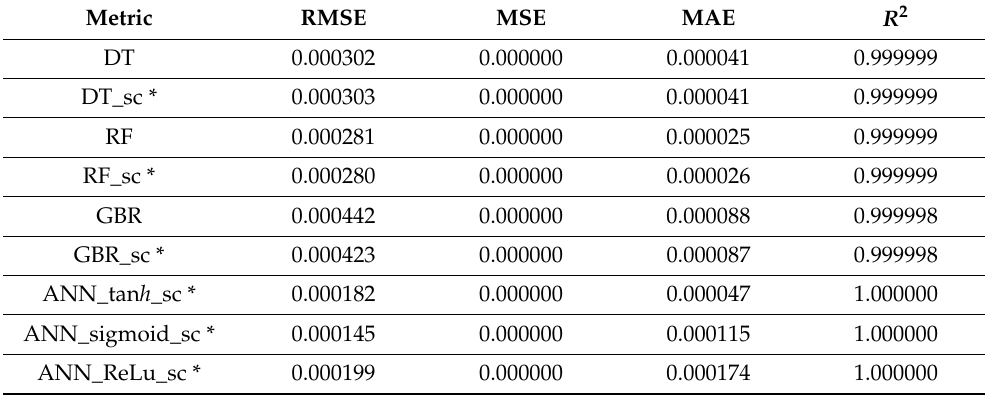
Table 7. Models performance evaluation of two phases dataset for k rop .